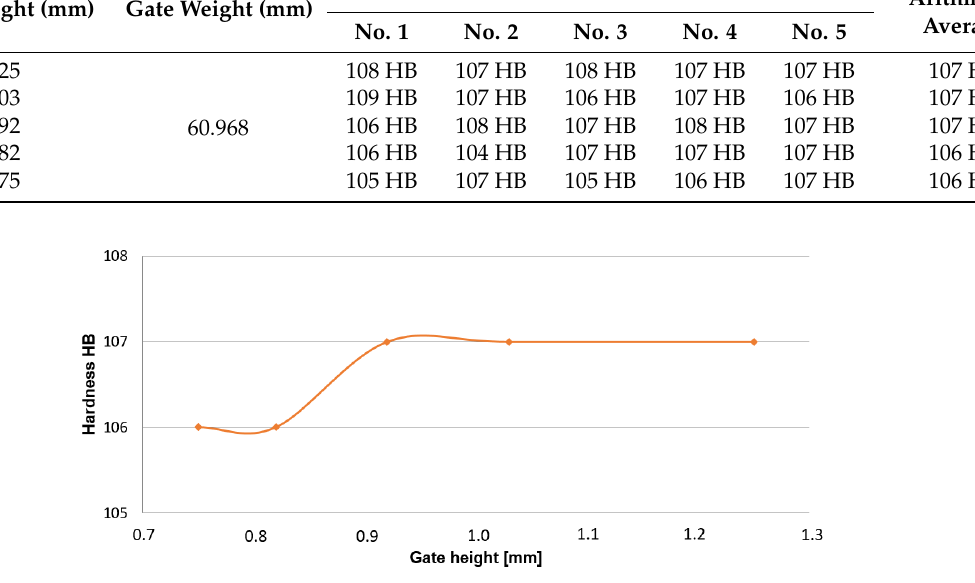
Figure 15. RTG—Sample 4.C. Figure 16. RTG—Sample 1.B.